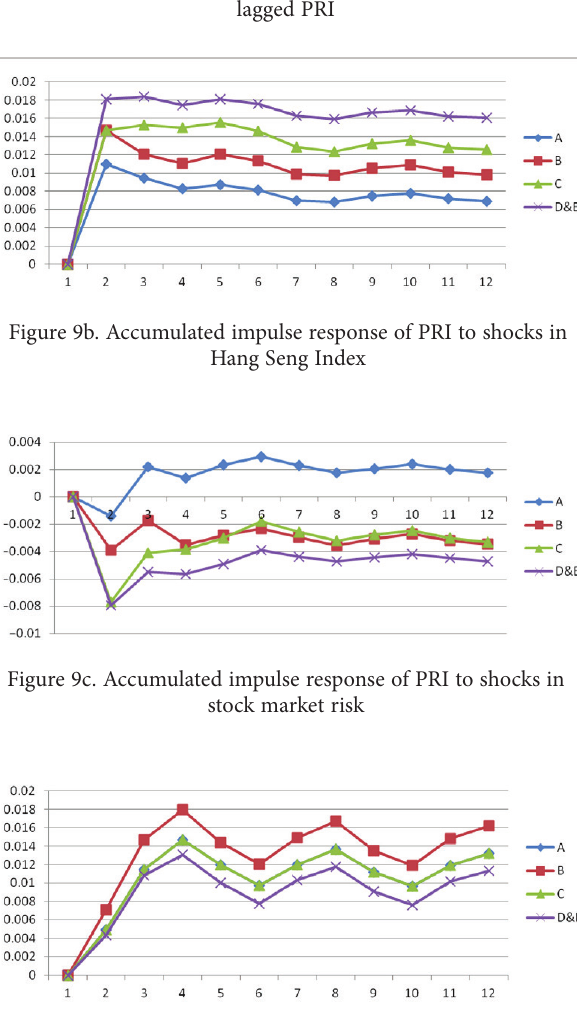
Figure 9i. Accumulated impulse response of PRI to shocks in money supply